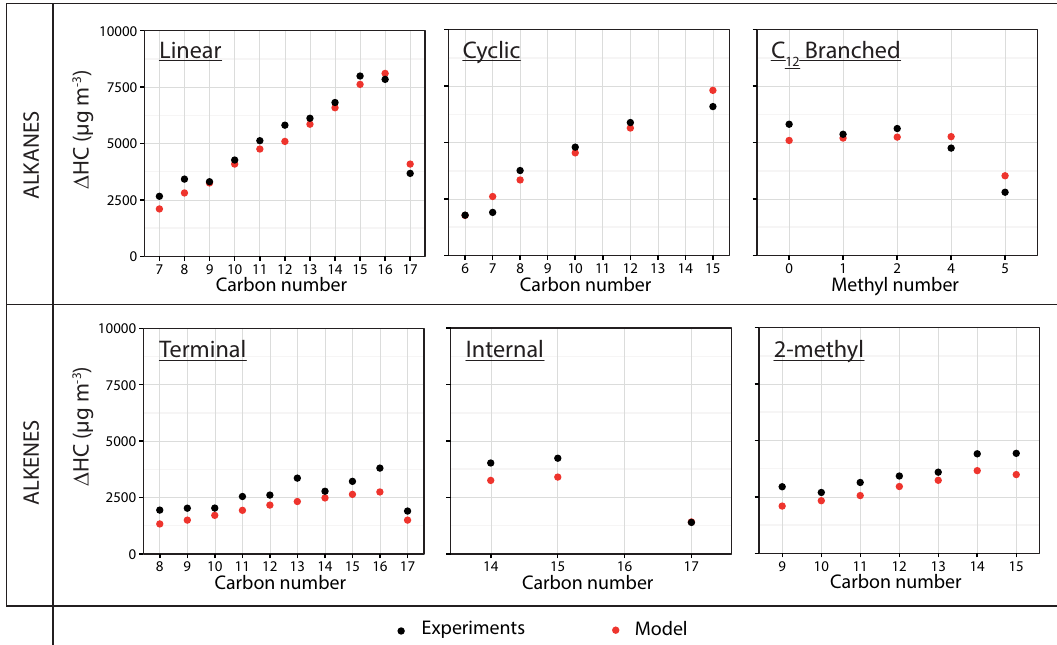
Figure 6. Comparison between the measured (black) and the simulated (red) (cid:49) HC mass for the different chemical families as a function of carbon chain length or number of methyl groups of the carbon backbone.